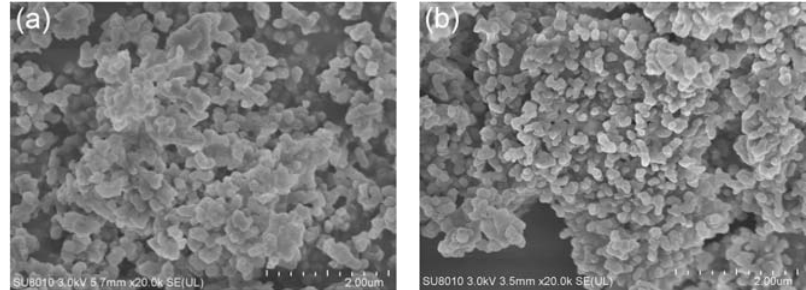
Figure 4. SEM (scanning electron microscope) images of M ‐ NEPCMs (Micro ‐ nanoencapsulated